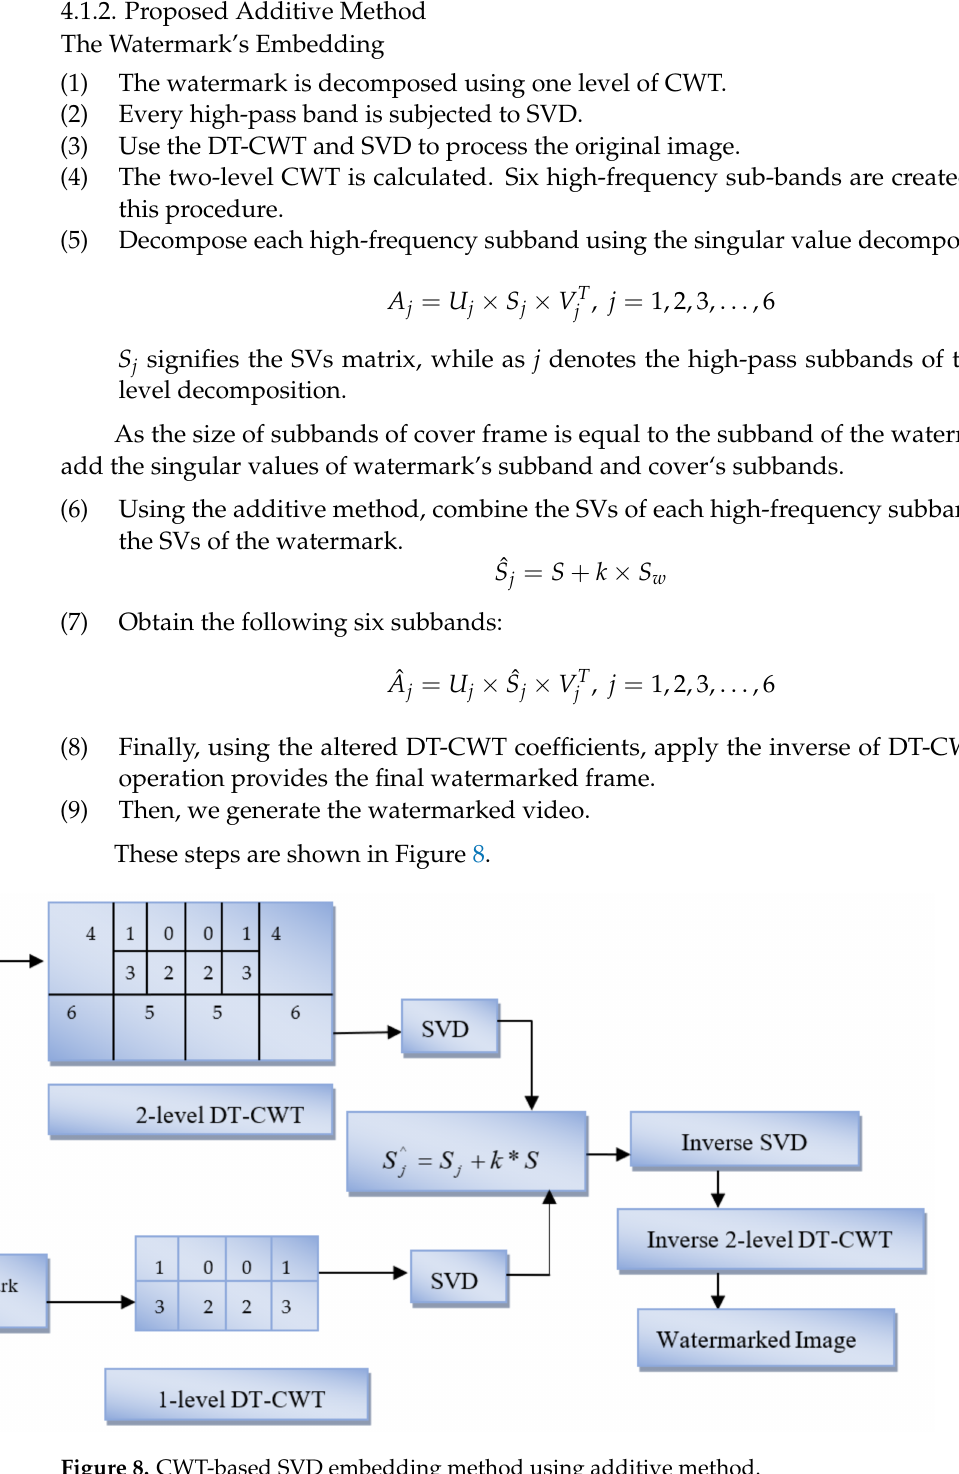
Figure 8. CWT-based SVD embedding method using additive method. Extraction of the